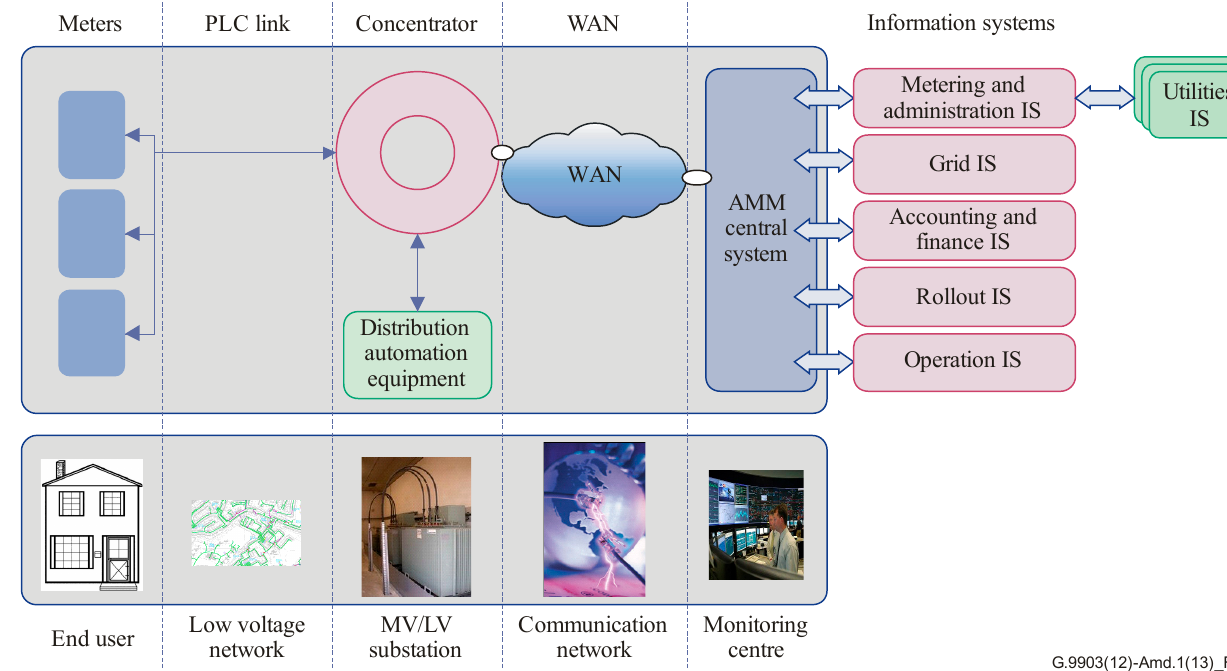
Figure 1. Generic architecture of an Advanced Metering Infrastructures (AMI) with last-mile Power line communications (PLC) connectivity (source: ITU-T G.9903 [1]).